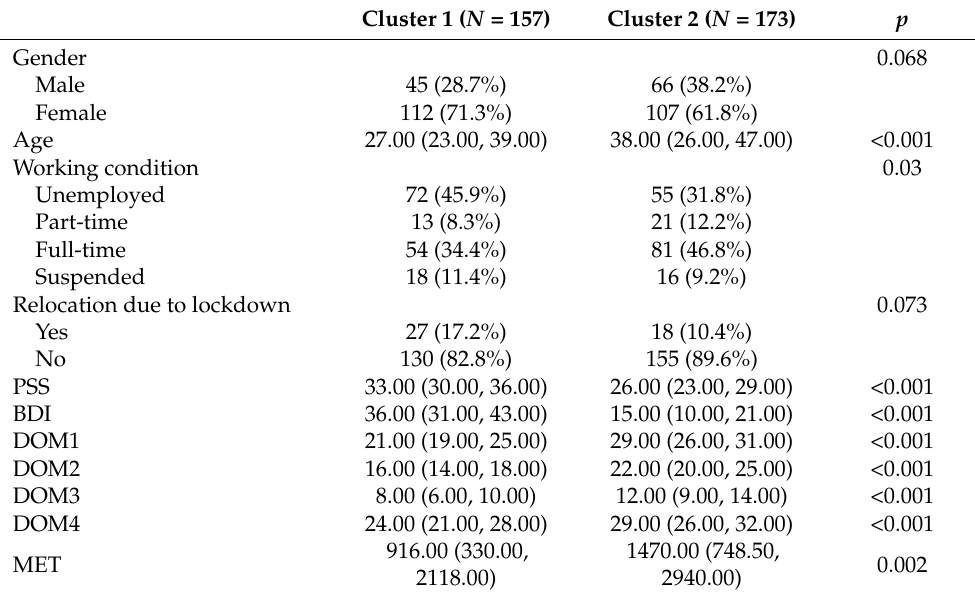
Table 7. Comparison Of Demographic and Clinical Characteristics Across the